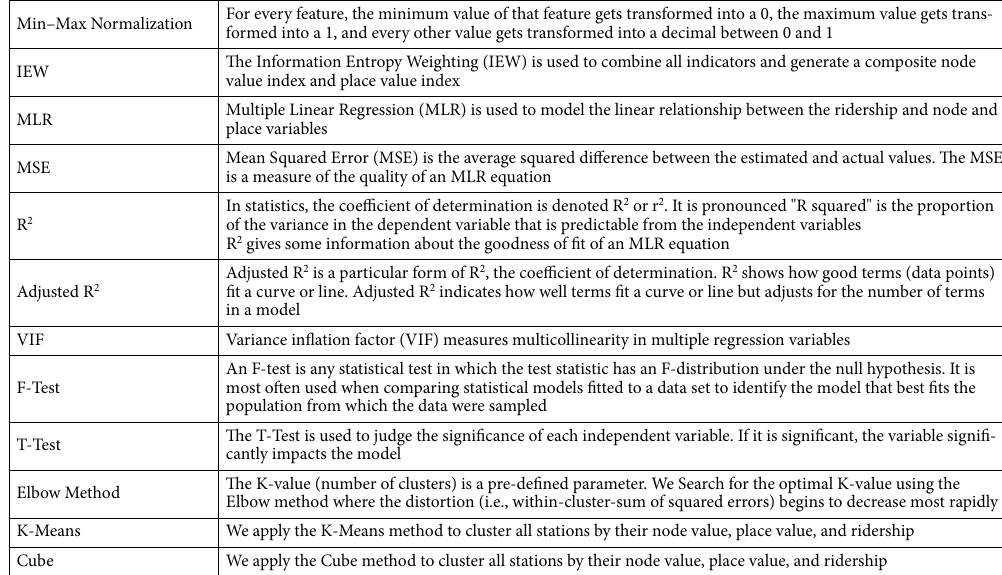
Table 1. Description of applied